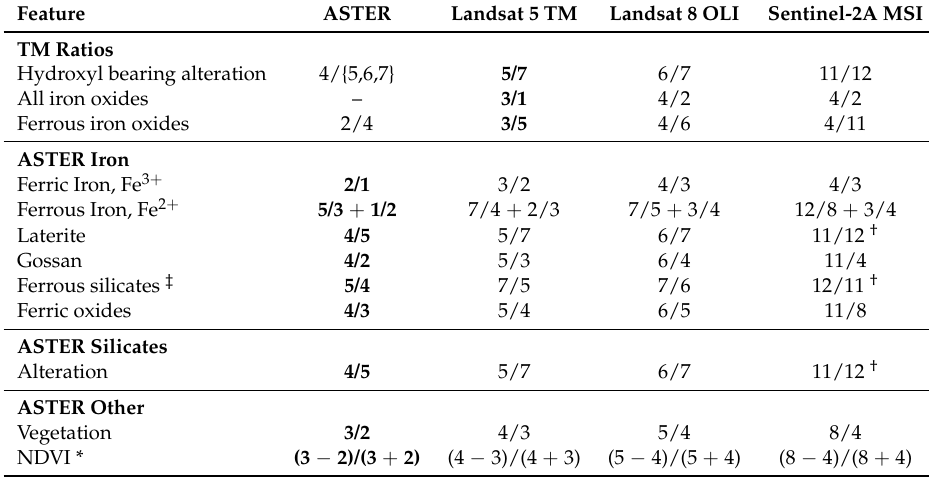
Table 2. Sentinel-2A MSI (MultiSpectral Instrument) and Landsat 8 OLI (Operational Land Imager) band ratios, as an analogue of Sabins [34] Landsat 5 TM (Thematic Mapper) and Kalinowski and Oliver [33] ASTER (Advanced Spaceborne Thermal Emission and Reflectance Radiometer) band ratios used as proxies for mapping mineralogy (modified after Van der Meer et al. [16]). The table is limited to band combinations that fall in the wavelength range of Sentinel-2A